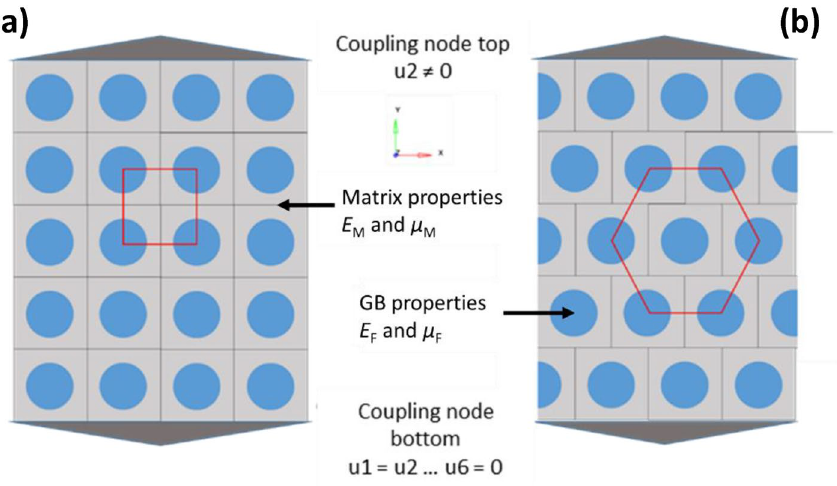
Figure 3. Cubic elementary volume model for FEA simulations: ( a ) cubic and ( b ) hexagonal lattice arrangements. Note that this EV representation holds also for unidirectional fiber systems if the load acts only perpendicular to the fiber axis.